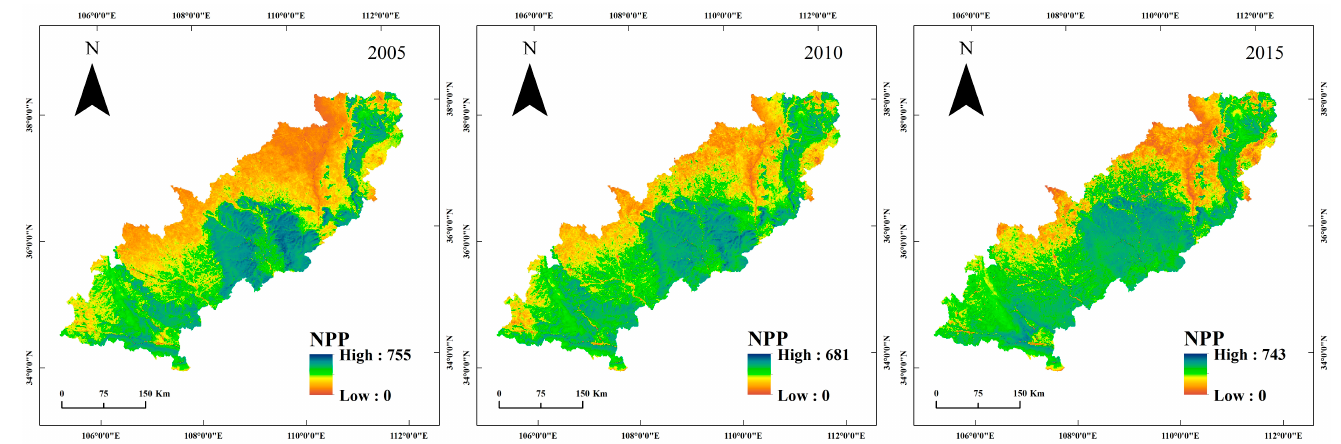
Figure 8. Distribution of NPP in the Loess Plateau Ecological Screen from 2005 to 2015.